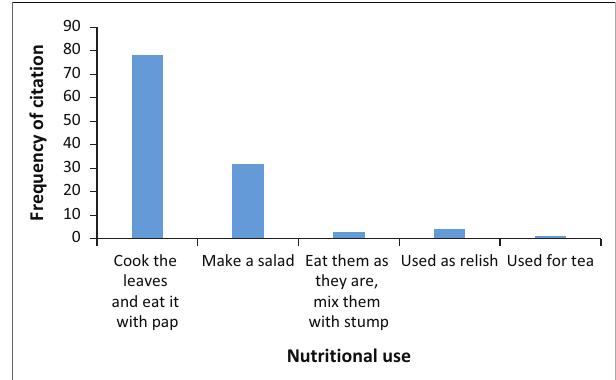
FIGURE 2: Nutritional use of indigenous leafy vegetables.